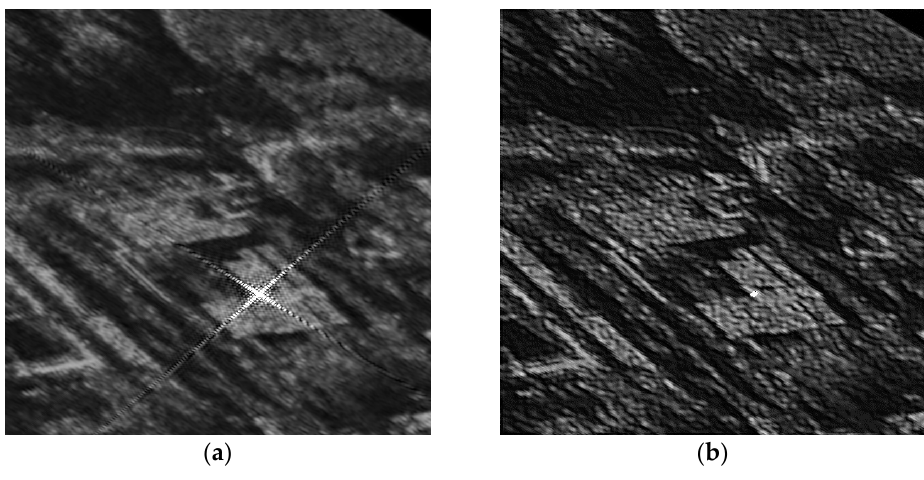
Figure 15. The unprocessed and processed squint SAR images ( a ) Unprocessed image; ( b ) Processed